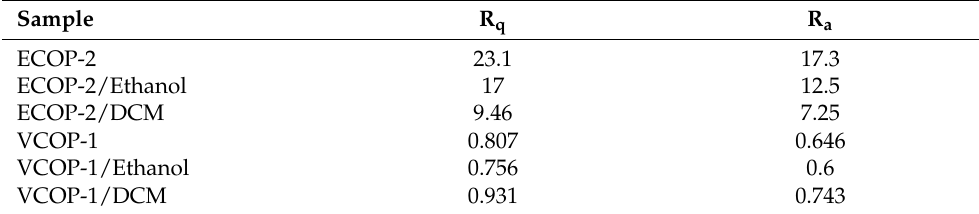
Table 2. Surface roughness changes for ECOP-2 and VCOP-1 copolymer coatings.